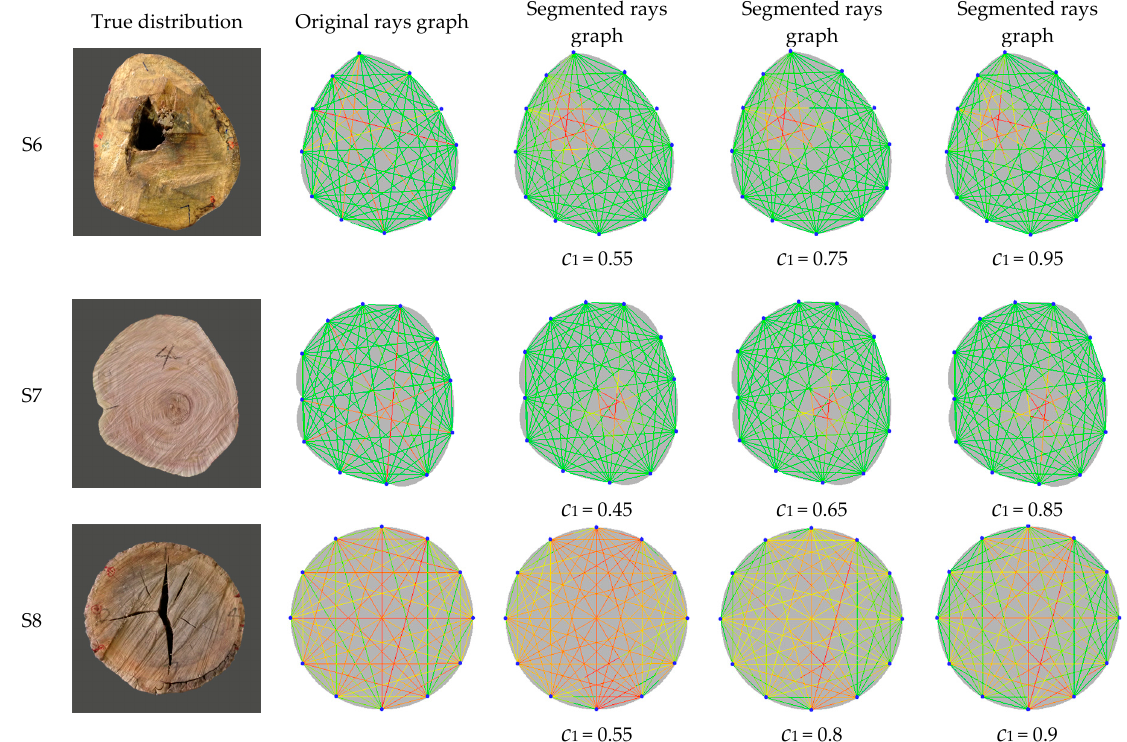
Figure 8. Original rays graph and segmented rays graph using the RSEN method from the real data with different control coefficients.